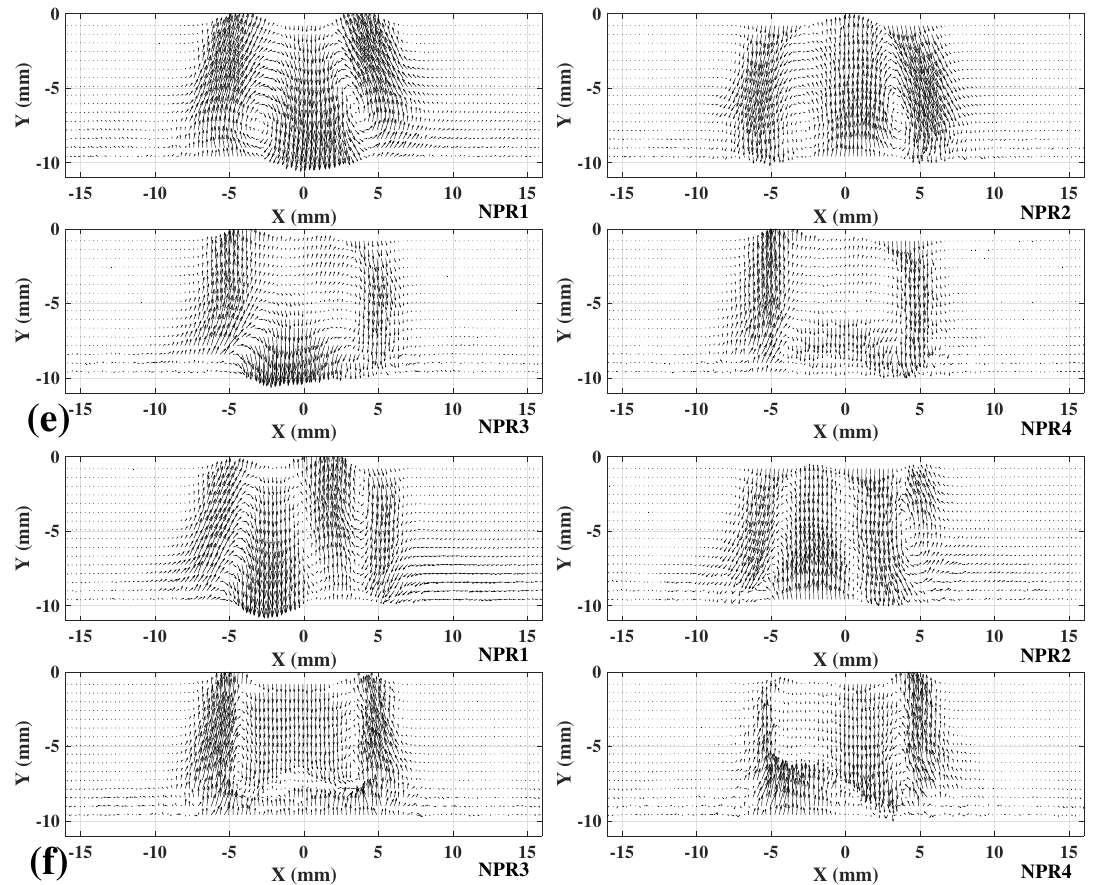
Figure 13. POD analysis of the velocity fields obtained from the 2D2C PIV measurements of impinging jets with e = 10 mm ( e / D j = 0.82) for NPR 1 = 2, NPR 2 = 2.2, NPR 3 = 2.5, and NPR 4 = 2.77. ( a ) Kinetic energy spectra; ( b ) cumulative energy. Low-order POD velocity modes ( c ) Ψ 1 , ( d ) Ψ 2 ; ( e ) Ψ 3 , and ( f ) Ψ 4 . Vectors were de-sampled for better